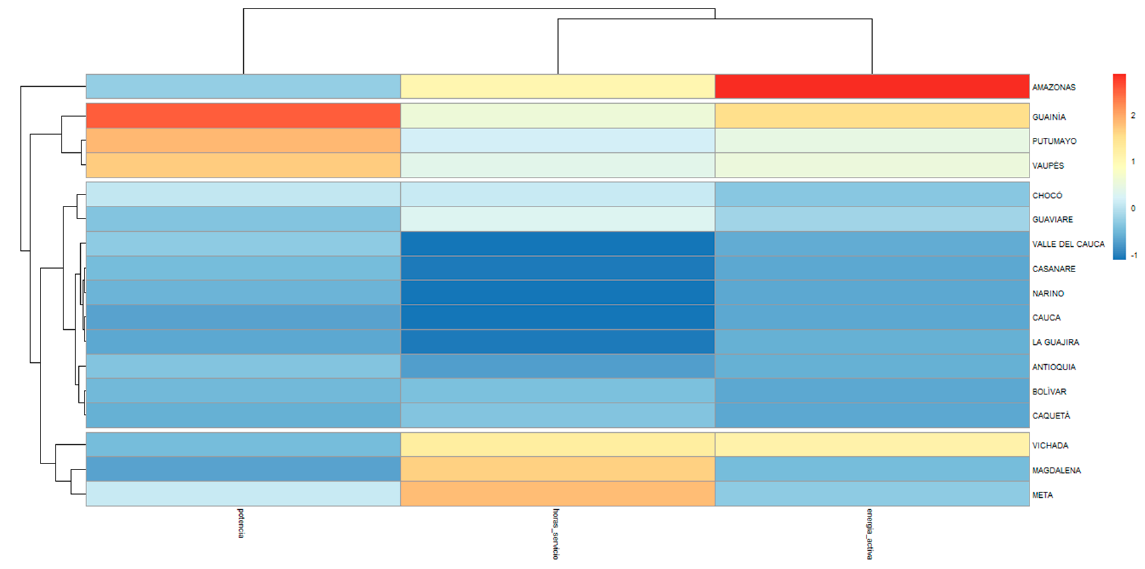
Figure 6. Heatmaps (shire counties, active energy, operating hours, and power).